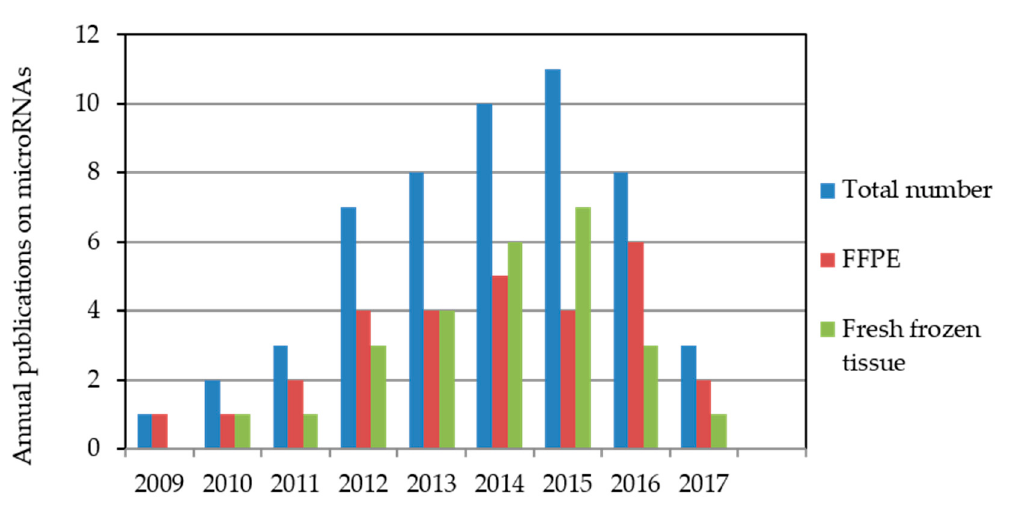
Figure 1. Annual microRNA publications indexed in the PubMed database relating to biochemical recurrence after radical prostatectomy. The literature search was performed for the period from October 2008 to May 2017 with miRNA measurements in formalin-fixed, paraffin-embedded (FFPE) or fresh-frozen tissue samples. Two studies used both FFPE and fresh-frozen tissue samples